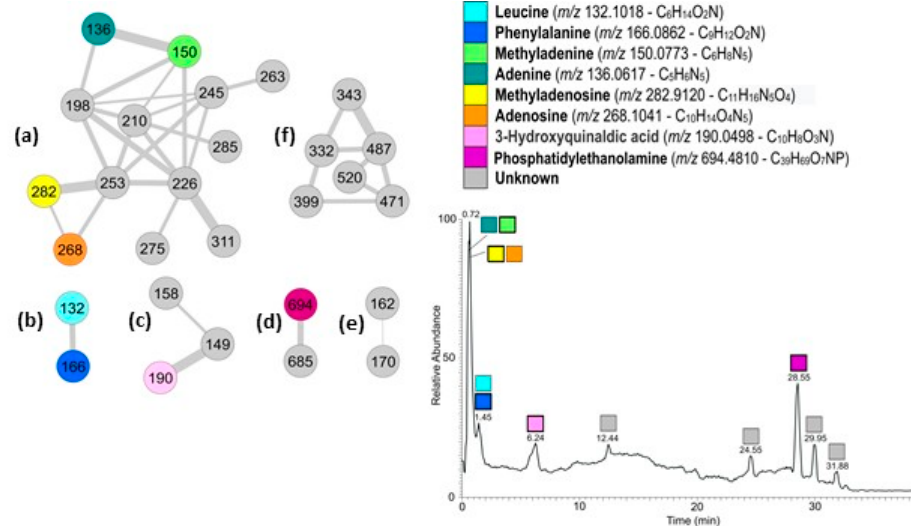
Figure 2. ( Left ) Two-dimensional molecular network of the active fraction from the sponge Geodia cydonium. In the clusters indicated with ( a – f ), nodes are labeled with parent m / z ratio (M+H) + ions; edge thickness is related to cosine similarity score; ( Right ) Liquid chromatography-high resolution mass spectrometry (LC-HRMS) profile of the active fraction; the most abundant ions are represented by colored bold contour squares.